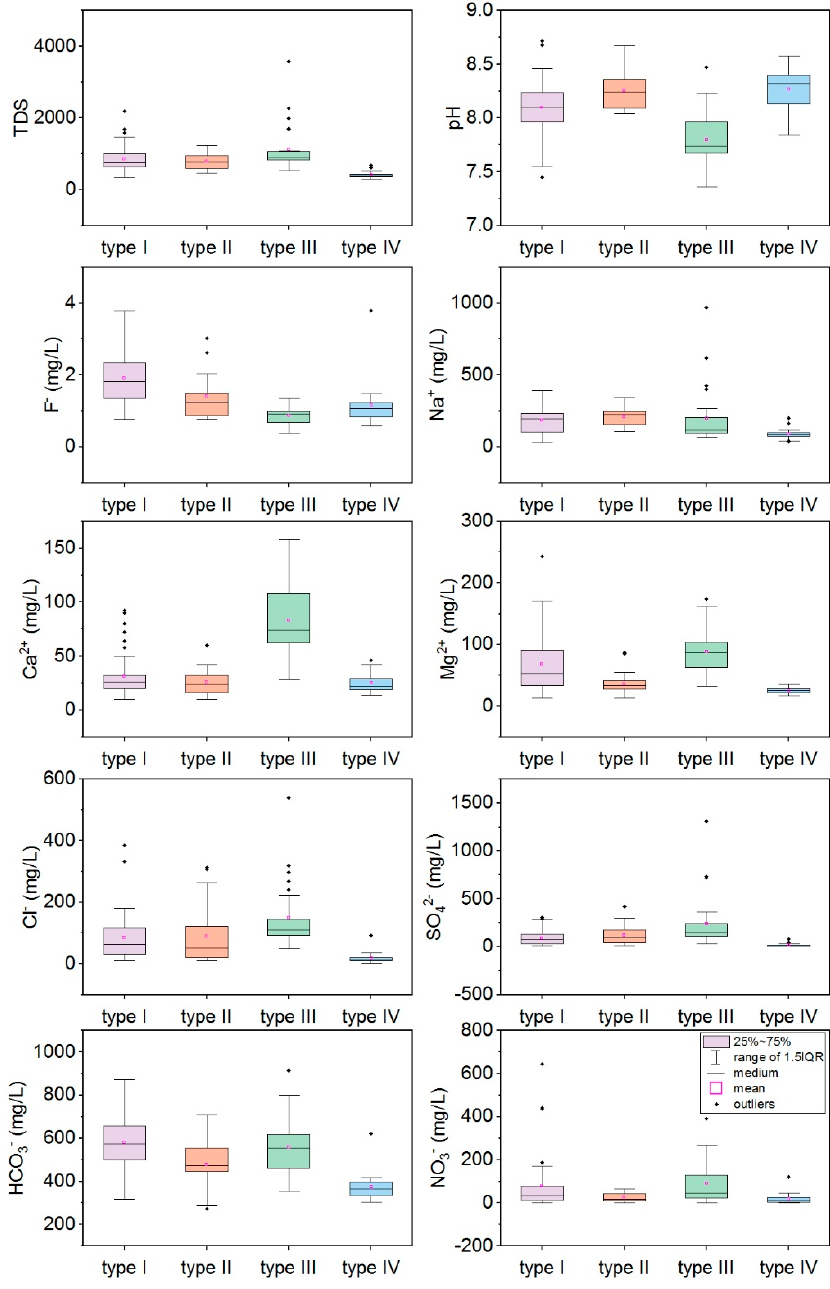
Figure 3. Box plots for the major ions (TDS, pH, F − , Na + , Ca 2 + , Mg 2 + , Cl − , SO 42 − , HCO 3 − , NO 3 − ) in four groundwater aquifers. Type I water came from a shallow loess aquifer, type II water from a deep alluvial aquifer, type III water from a shallow alluvial aquifer, and type IV water from a deep fracture